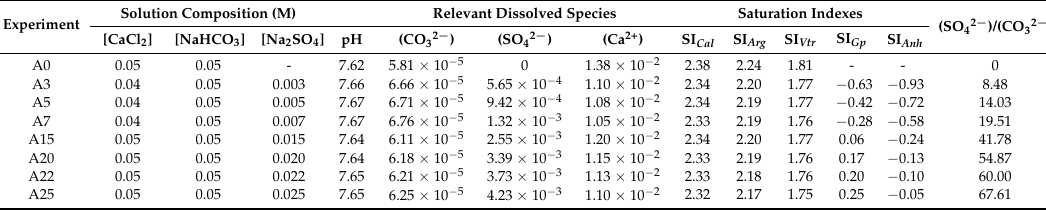
Table 1. A summary of the initial fluid